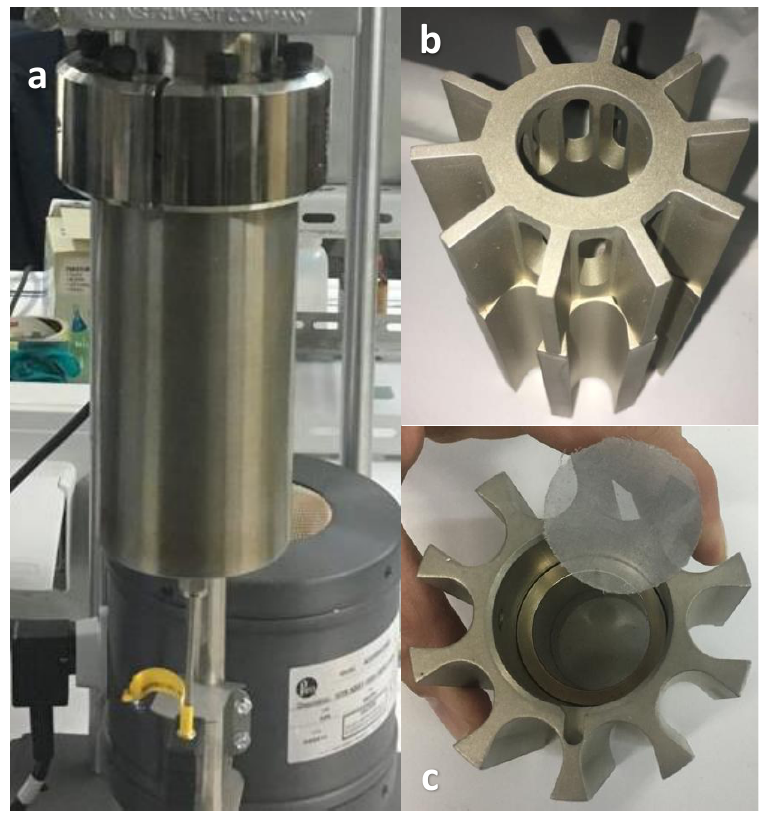
Figure 12. Pictures of the reactor vessel ( a ) and of the flow guide ( b ) with a zoom on the catalyst basket ( c ).